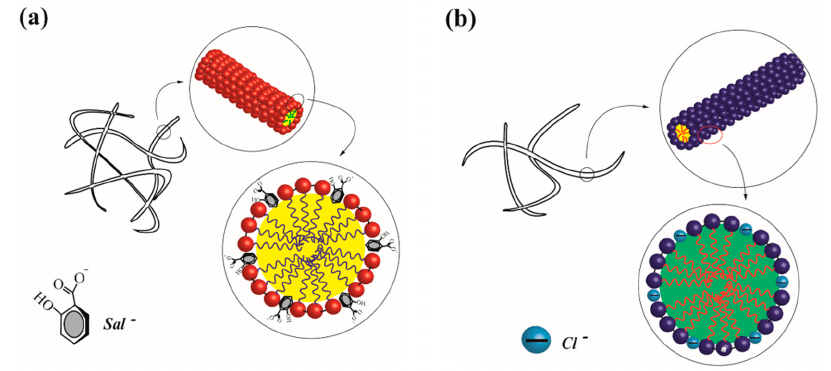
Figure 9. ( a ) Schematic diagram for Sal − to affect micelle shape transition; ( b ) Schematic diagram for Cl - to affect micelle shape transition.